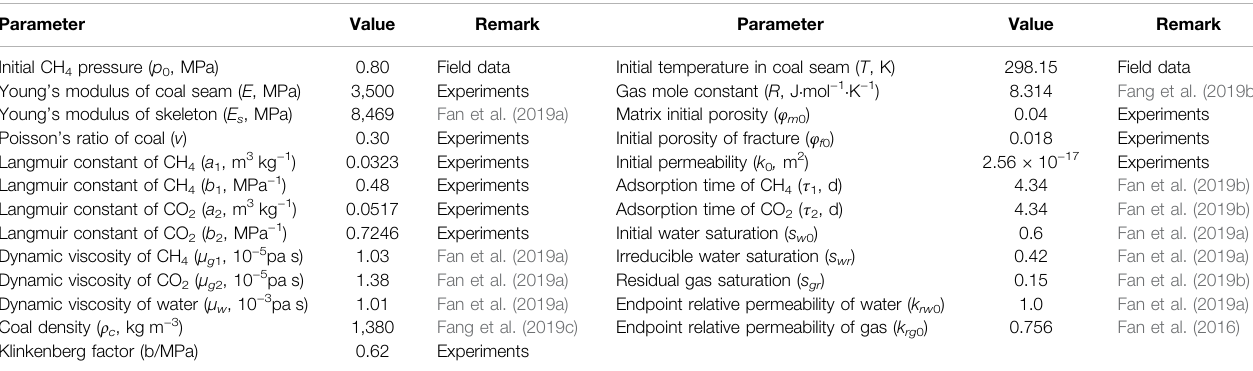
TABLE 1 | Numerical simulation